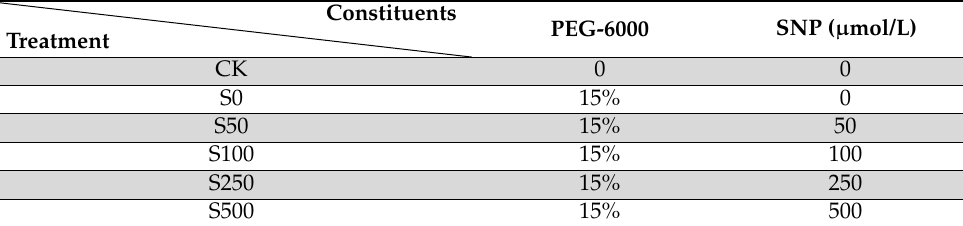
Table 1. Test treatment method. PEG-6000 was dissolved in water and then watered in pots, and SNP was sprayed on soybean leaves by front and back spray.